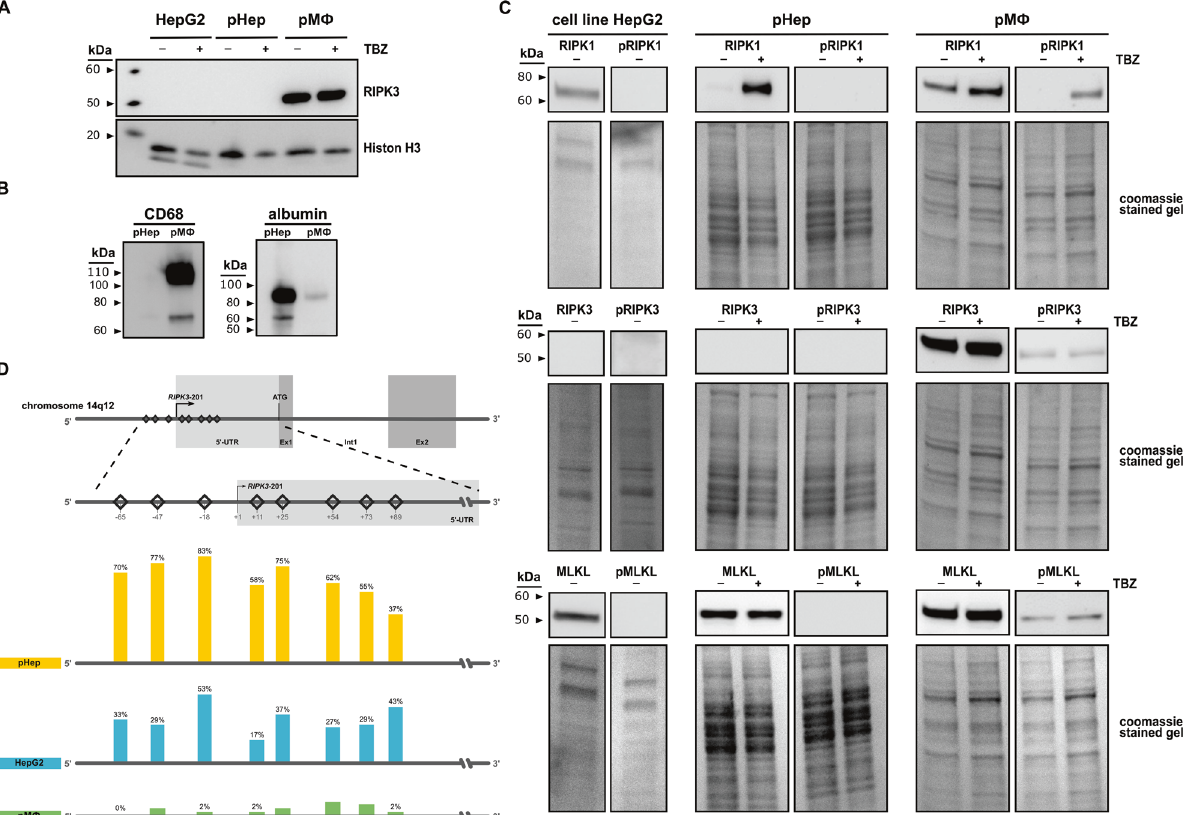
Fig. 1 Necroptosis signaling is absent in primary human hepatocytes under physiological conditions. A Protein expression of RIPK3 in HepG2 cells, primary human hepatocytes (pHep), and primary human macrophages (pM Ф ). ( + ) indicates TBZ stimulation with necroptosis- inducing reagents where cells were pre-incubated for 0.5 h with BV6 (5 µmol L − 1 ) and zVAD-fmk (20 µmol L − 1 ) before stimulation with TNF- α (20 ng mL − 1 ) for 6 h. Histone H3 and coomassie-stained gels were used to control the loading. B Protein expression of molecules with high abundance in hepatocytes (albumin) or macrophages (CD68) are detected to assess the purity of the pHep and pM Ф . C Protein expression of molecules in the necroptosis signaling pathway detected in HepG2 cells, pHep, and pM Ф . ( + ) indicates TBZ stimulation with necroptosis- inducing reagents where cells were pre-incubated for 0.5 h with BV6 (5 µmol L − 1 ) and zVAD-fmk (20 µmol L − 1 ) before stimulation with TNF- α (20 ng mL − 1 ) for 6 h. Coomassie staining of SDS-PAGE gel was used as a loading control. n = 2 – 5. D Pyrosequencing detected RIPK3 promoter methylation analysis in pM Ф , pHep, and the hepatocellular carcinoma cell line (HepG2). Bars and numbers depict the mean percentage of methylated cytosine in the different promoter regions of each sample. Sequencing was performed on 1 (pHep, pM Ф ) or 2 (HepG2 cells) individual samples, each containing DNA from 1 million cells. Statistics: Figure Data, additional statistical information, and p values are provided in Supplementary Materials 2 and